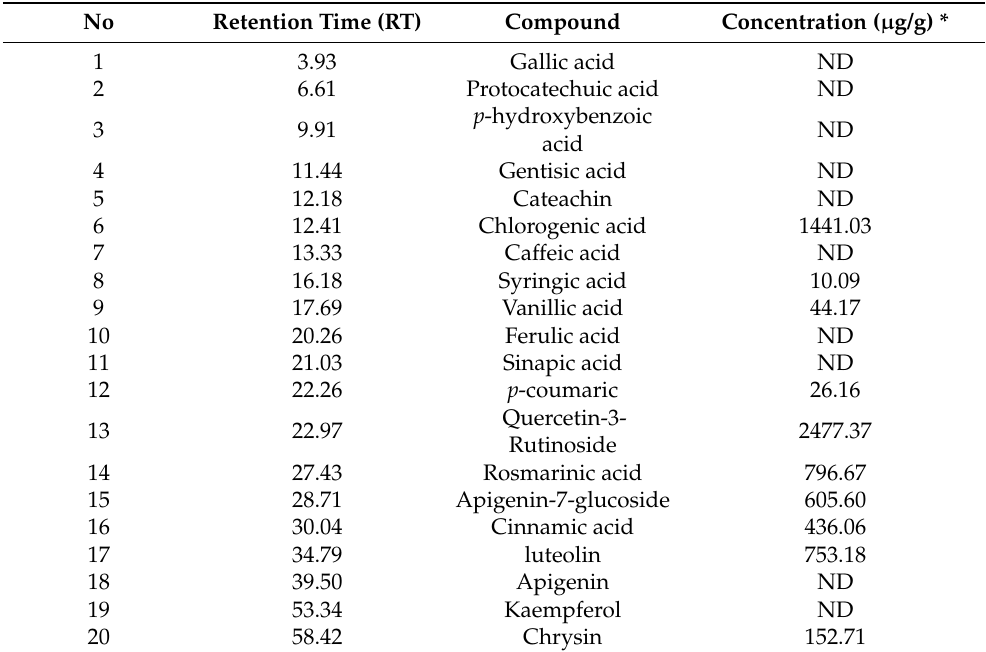
Figure 1. HPLC-DAD of GTLE (320 nm). Chl—chlorogenic acid; syr—syringic acid; van—vanillic acid; p- co— p- coumaric acid; q-rut—quercetin rutinoside; ros—rosmarinic acid; cin—cinnamic acid; api—apigenin; lut—luteolin; chr—chrysin. Table 1. Chemical composition analysis of the phenolic and flavonoid compounds of GTLE by